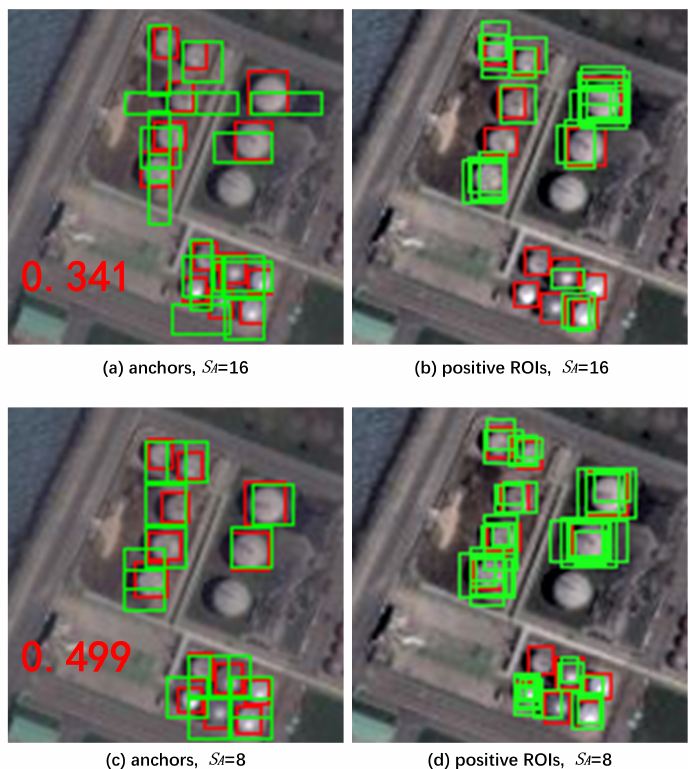
Figure 6. Anchors and positive ROIs which participate in network training. S A mean the stride of the anchors in different detection framework. When we use dilated convolution in Res5 stage, S A = 16 as shown in the first row images. When we use dilated convolution in Res4 and Res5 stage, S A = 8 as shown in the second row images. The green bounding box represents the anchor or positive ROI, the red represents ground truth. Numbers in the first column images are the average IoU value of the positive anchors corresponding to the small objects exist in this